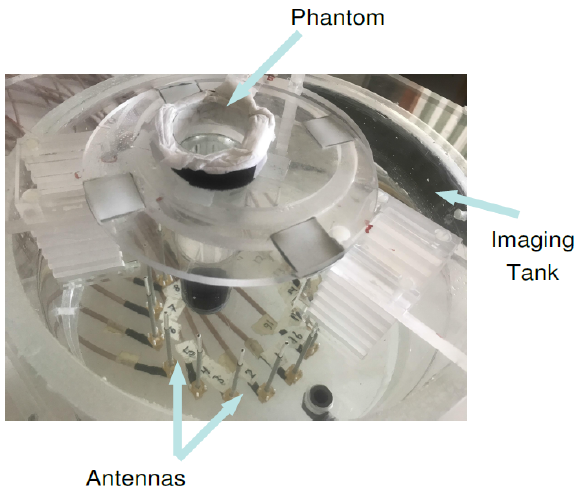
Figure 10. The photograph of the measurement setup for the case that a cylindrical inclusion is positioned close to antennas #6 and